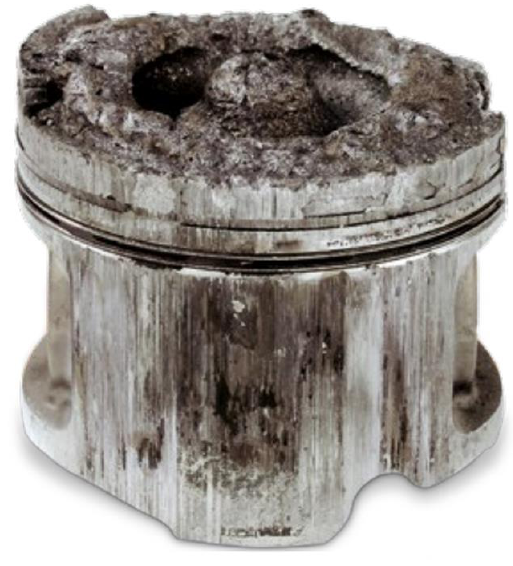
Fig. 5. Diesel engine piston with a melted bottom [21]